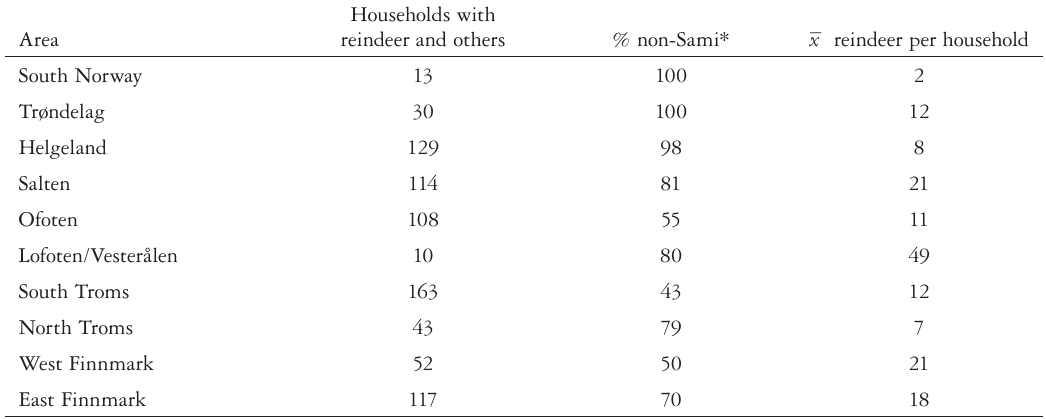
Table 1. Number of households owing reindeer as part of their livestock in 1875. (Source: National census 1875, digitalized edition, Registreringssentralen for historiske data -RHD)